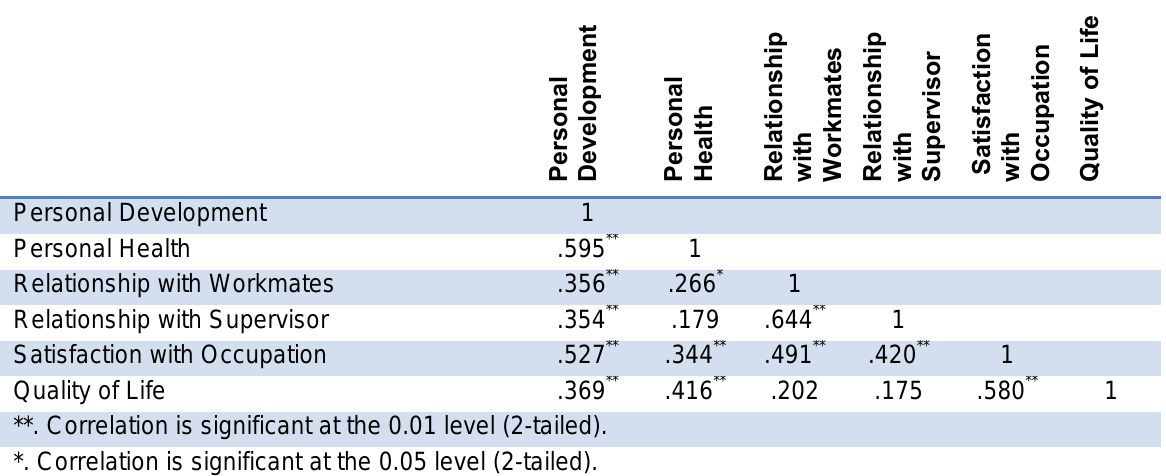
Table 5: Pearson correlation coefficients for job satisfaction scores items